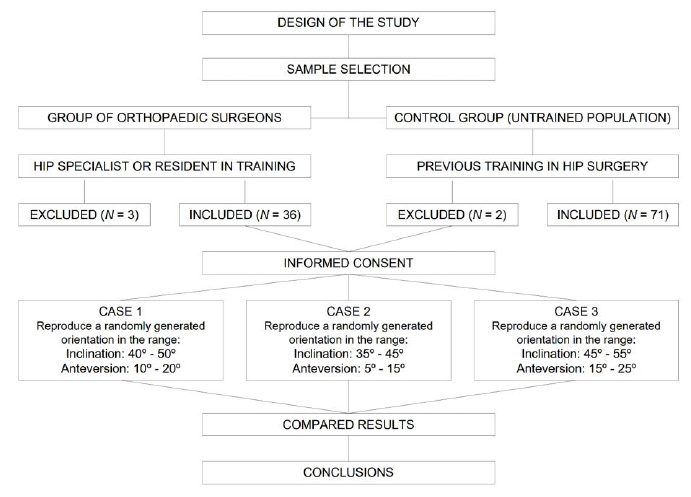
Figure 1. Workflow of the study.